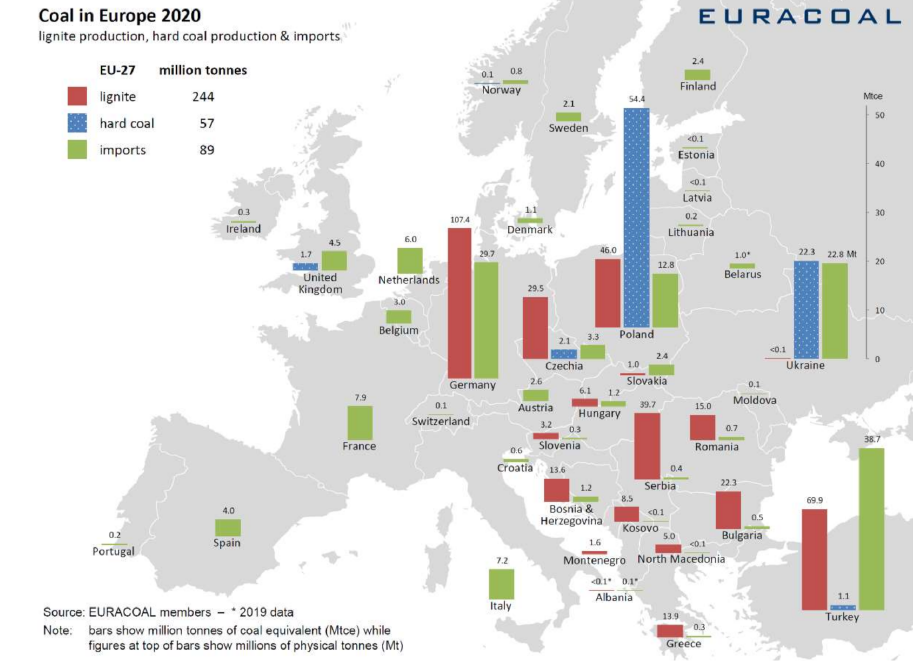
Figure 11. Coal map of Europe